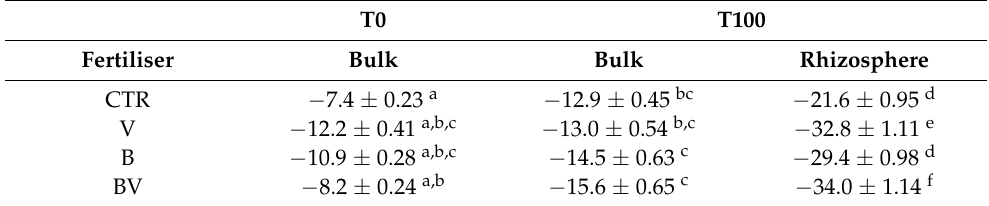
Table 5. Alteration index three (AI3) of bulk and rhizosphere soils amended with different fertilisers at the start (T0) and end (T100) of tomato cultivation. CTR—control; V—vermiwash; B—biochar; BV—biochar together with